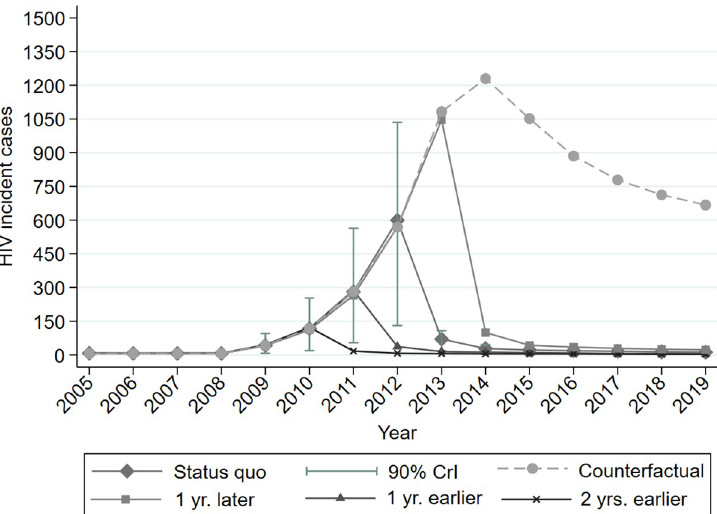
Fig 2. Model predictions for Human Immunodeficiency Virus (HIV) incident cases by the 5 different scenarios (status quo, counterfactual, one-year earlier/later implementation of interventions, and 2-year earlier implementation of interventions scenario). The shaded grey error bars show the 90% credible intervals (90% CrI) for the model projections.